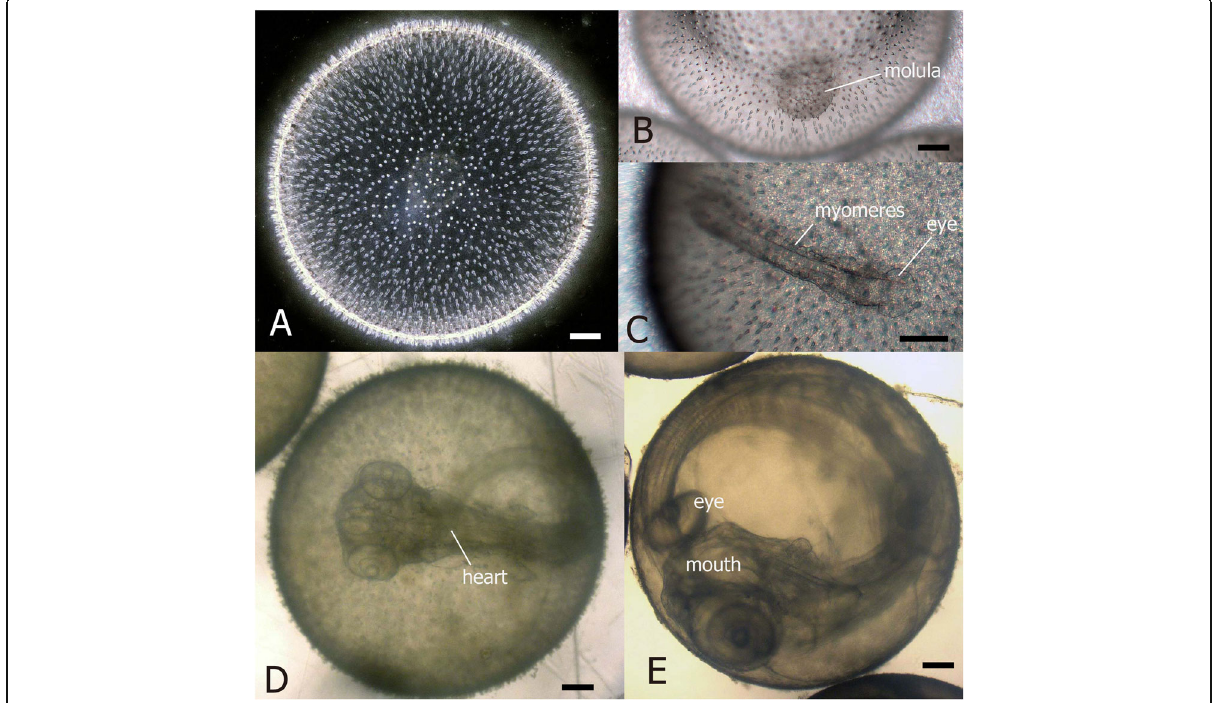
Fig. 2 Fertilized eggs of Regalecus russelii. a : immediately after fertilization, b : morula at 1 day after fertilization (DAF), c : embryo at 7 DAF, showing eye and myomere development, d : egg at 11 DAF, E: egg just before hatching (16 DAF). Scale bars: 0.2